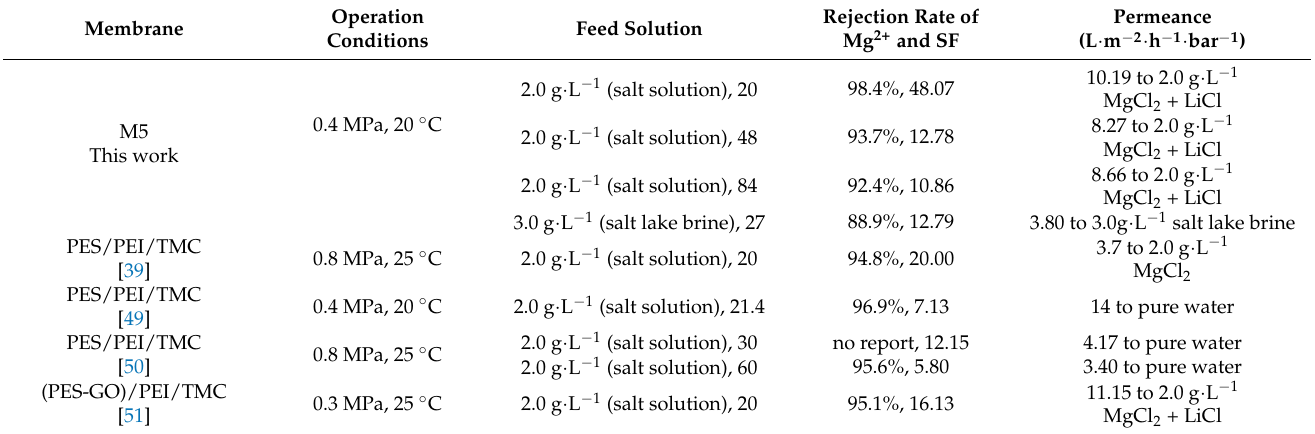
Table 4. Comparison of separation performance of NF membranes in the literature and this